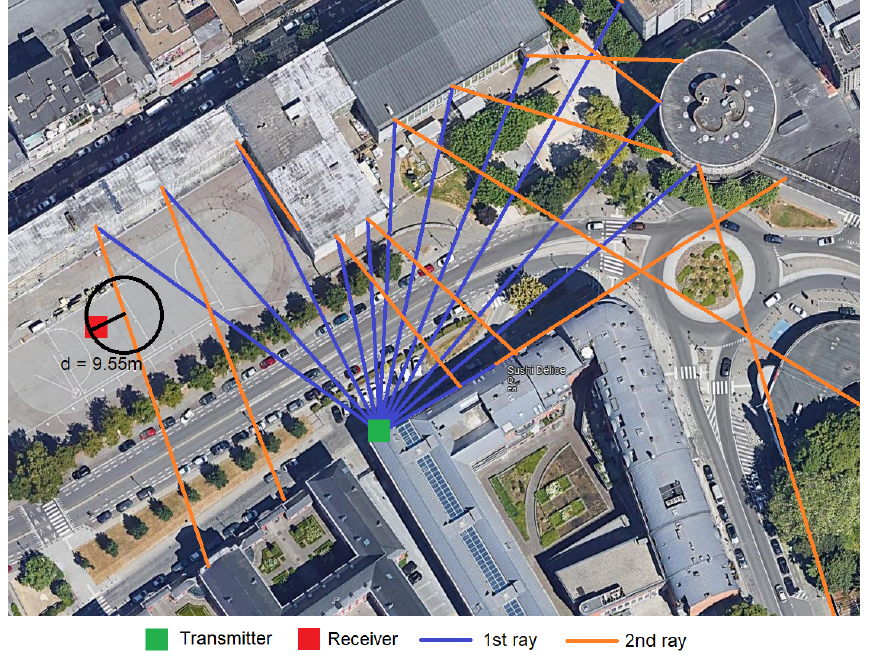
Figure 6. Ray tracing algorithm